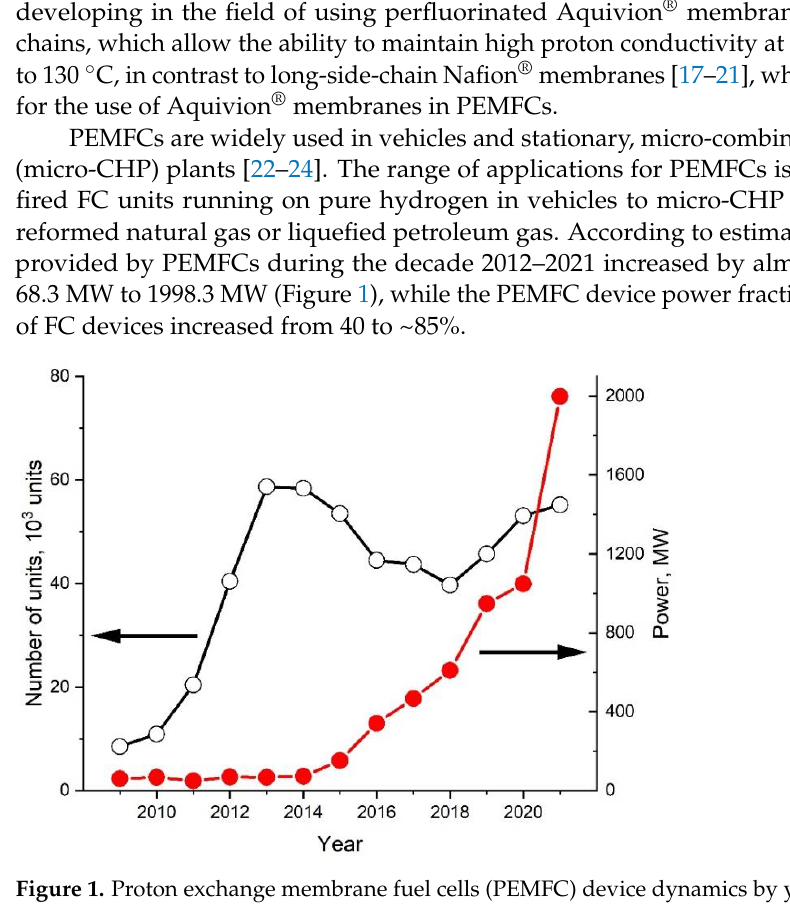
Figure 1. Proton exchange membrane fuel cells (PEMFC) device dynamics by year (number of units and power provided) (data adopted from [25]).